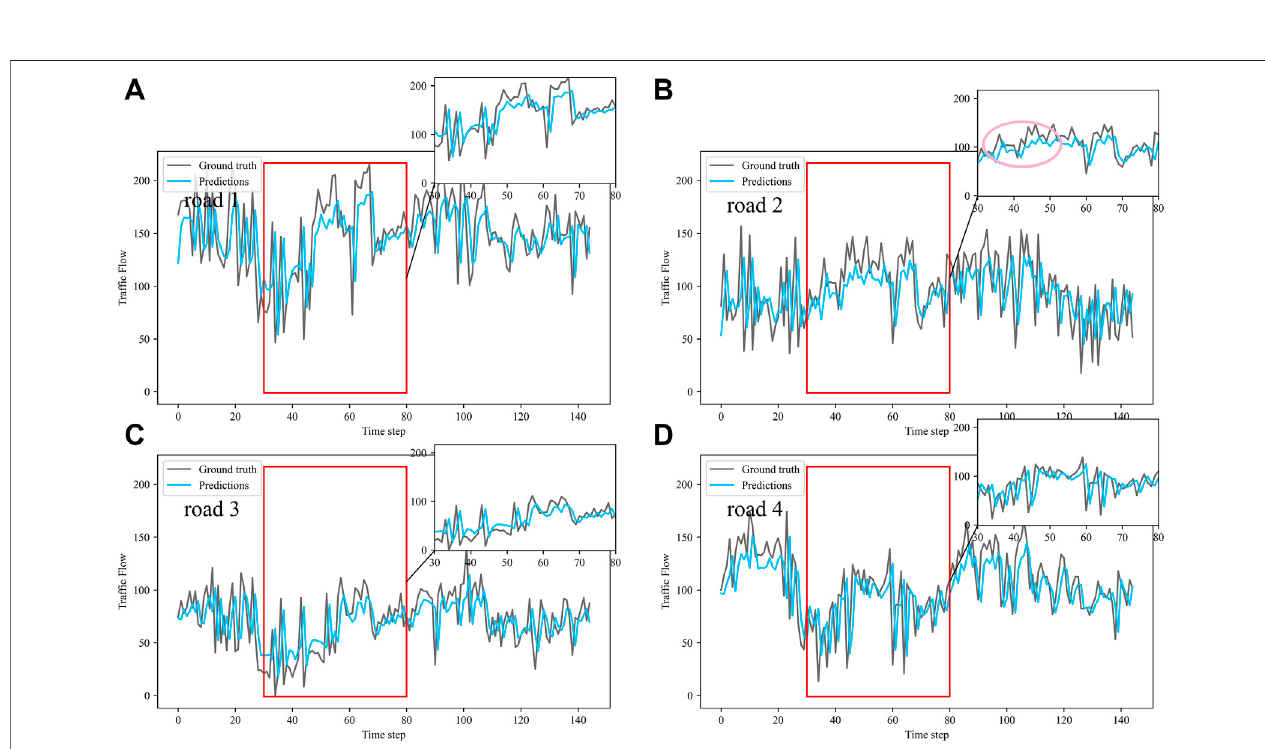
FIGURE 13 | Visualization of IMgruGcn model prediction results on peak dataset. (A) road 1 means Gudun Road. (B) road 2 means Fengtan Road. (C) road 3 means Yile Road. (D) road 4 means Jingzhou Road.